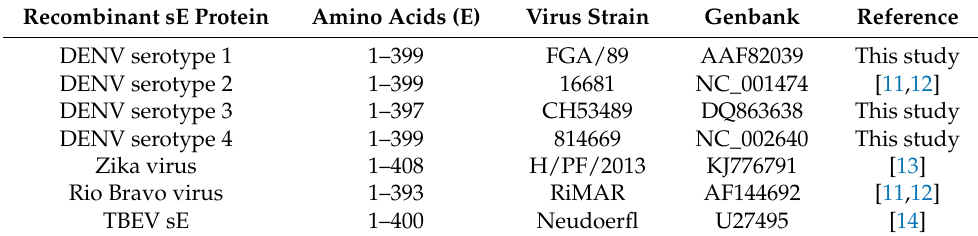
Table 1. Recombinant soluble E (sE) proteins used as antigens in